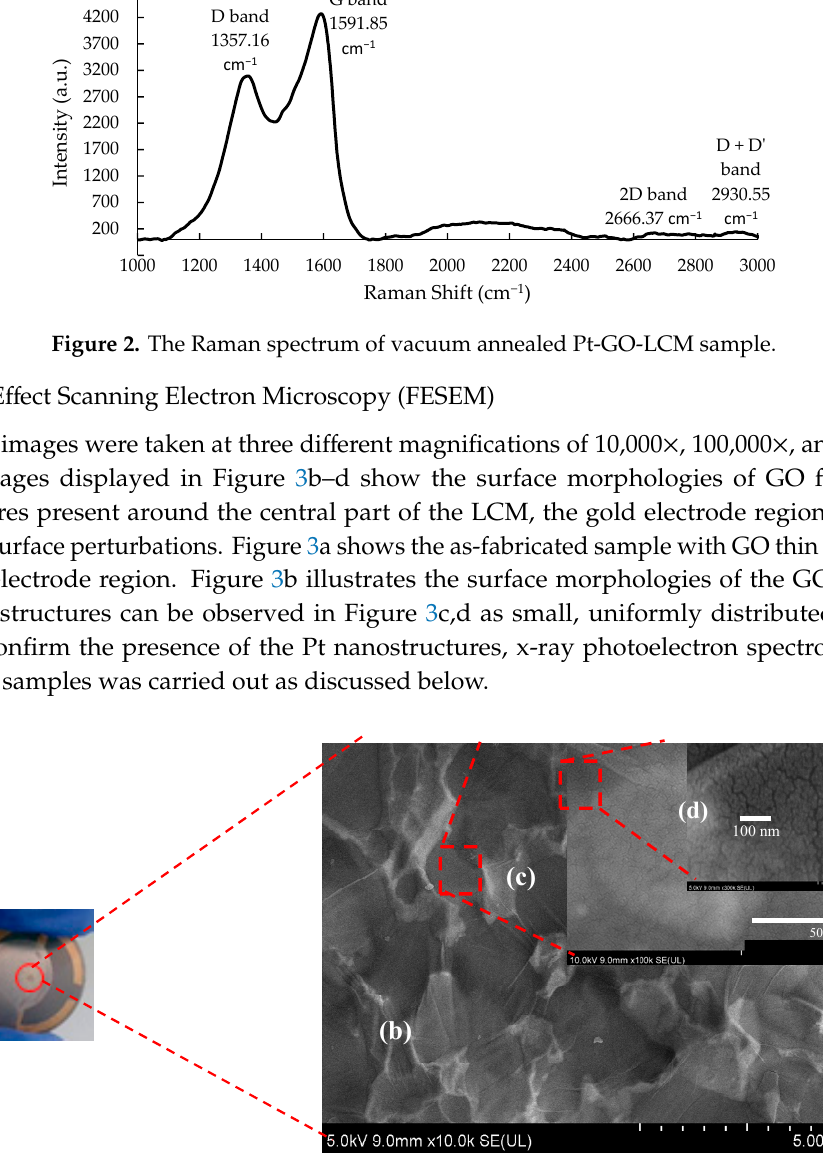
Figure 3. Photograph of as-fabricated Pt-GO-LCM sensor ( a ) and FESEM images obtained from the central Au electrode region of the device at 10,000 × ( b ), 100,000 × ( c ), and 3,000,000 × ( d ) magnifications.